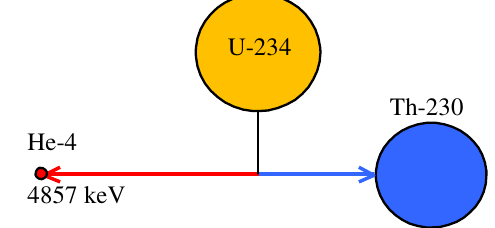
Figure 1. Schematic representation of 234 U